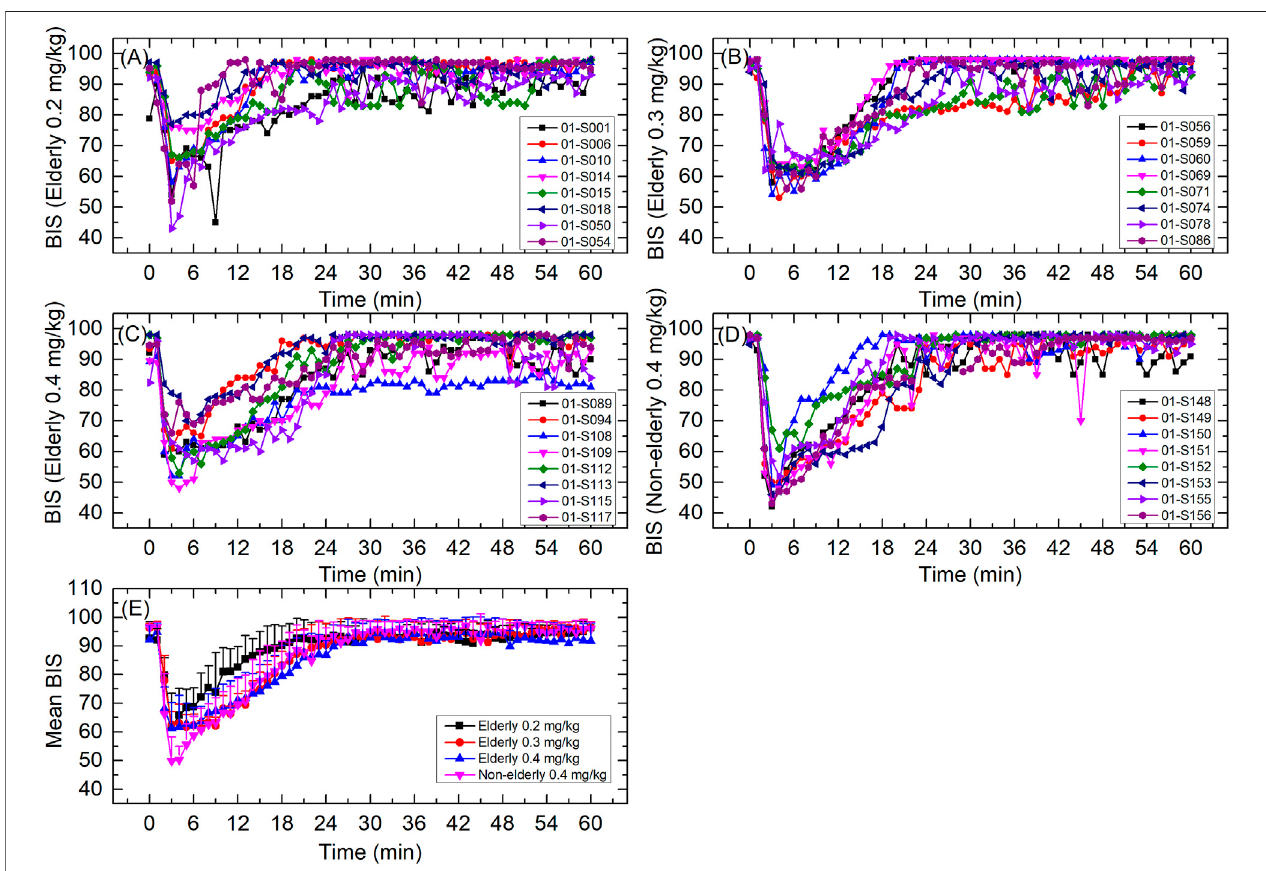
FIGURE 5 | BIS curves for (A) elderly 0.2 mg/kg; (B) elderly 0.3 mg/kg; (C) elderly 0.4 mg/kg; (D) non-elderly 0.4 mg/kg; and (E) mean for each group. Data are reported as mean + standard deviation for (E) .